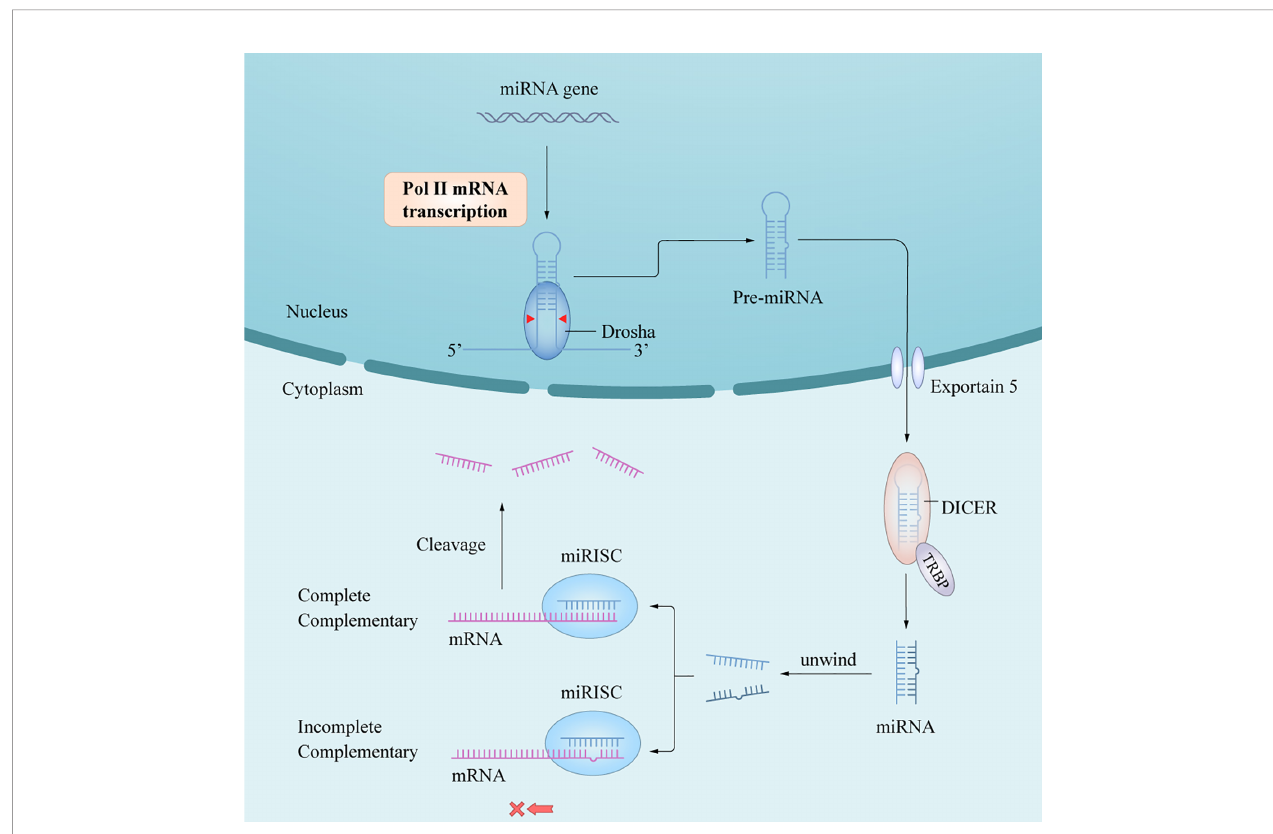
FIGURE 1 | A schematic of miRNA biogenesis. miRNA biogenesis begins in the nucleus, where genes are mainly transcribed by RNA polymerase II into pri-miRNAs. Pri-miRNAs are processed into pre-miRNA by the RNase III enzyme, Dorsha and DGCR8. After being transported into cytoplasm by Exportin-5/Ran-GTP, pre- miRNAs are further processed by Dicer and TRBP to yield miRNAs duplex. An functional miRNA strand is unwound from the miRNAs duplex and then loaded into the RISC to form an miRISC assembly, which are the functional forms of miRNAs and the regulator of gene expression in posttranscriptional level by interacting with the target